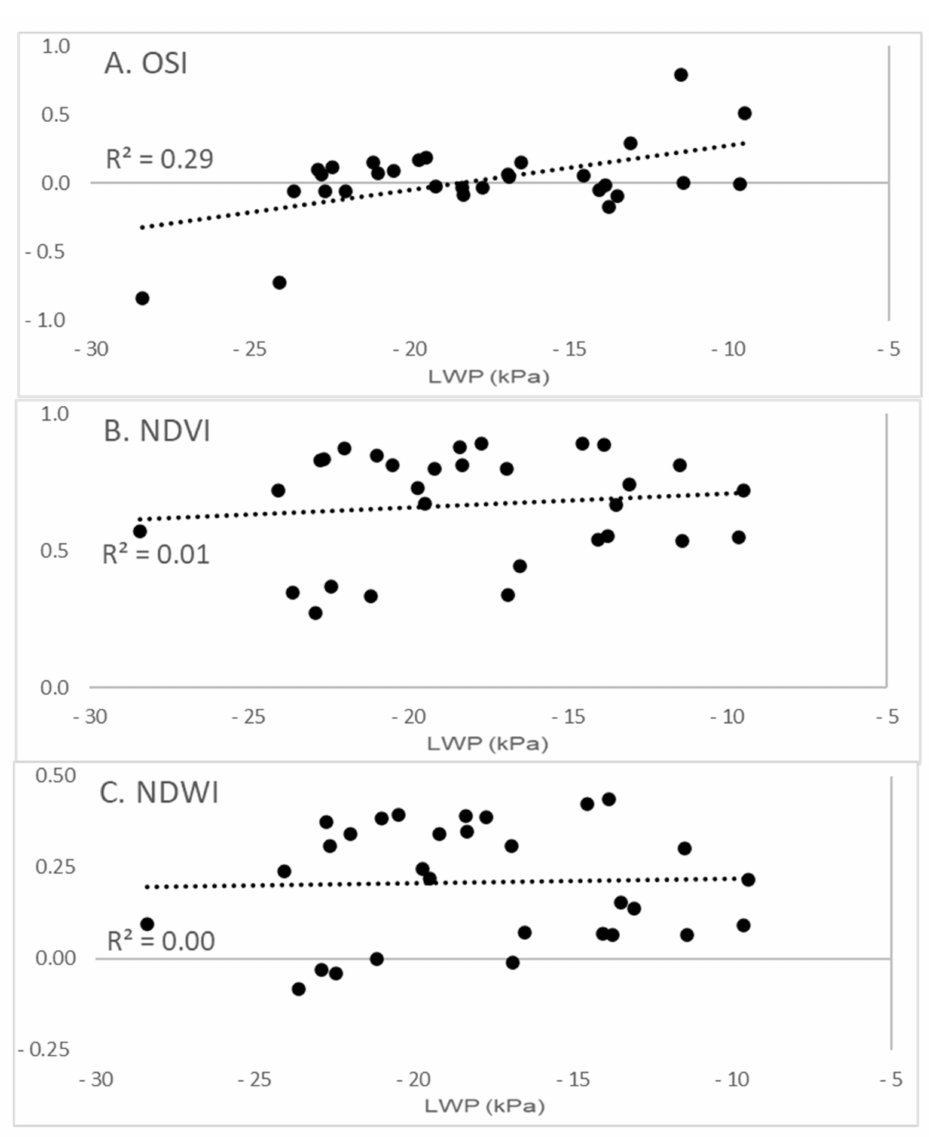
Figure A1. LWP and spectral indices